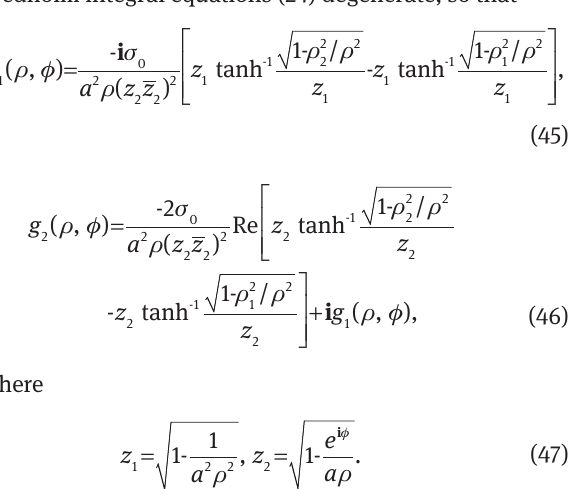
; each figure dis- 1 = 0, 0.1, 0.2, 0.4. 2